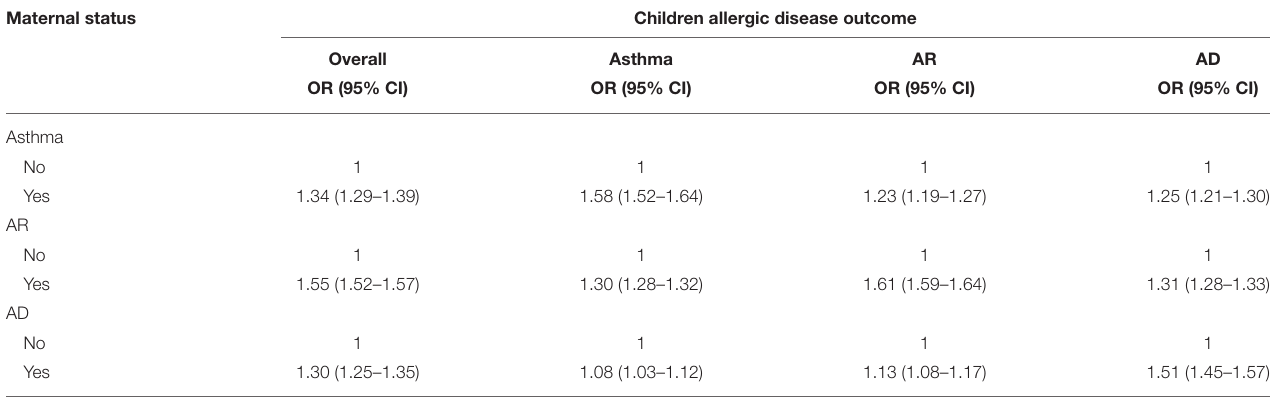
TABLE 3 | Risk of allergic diseases of children in different maternal allergic status. Maternal status